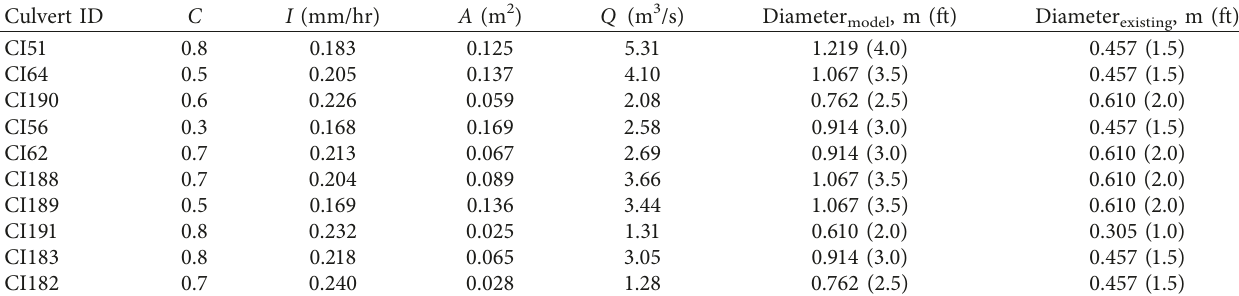
Table 5: Results of culvert designs for Tuscaloosa